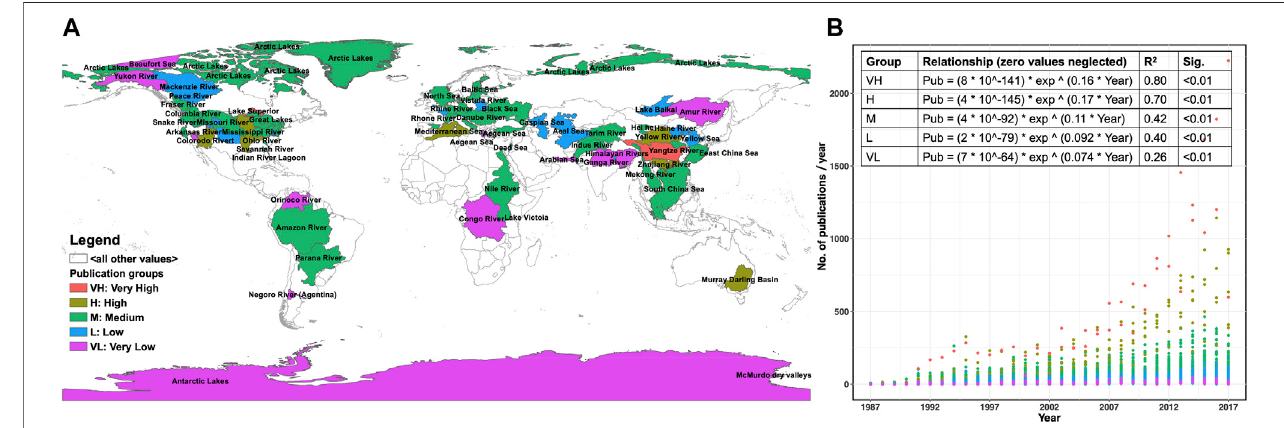
FIGURE 1 | (A) Spatial distribution of the fi ve publication groups in the chosen 95 river basins, and (B) temporal evolution of publications in each group.